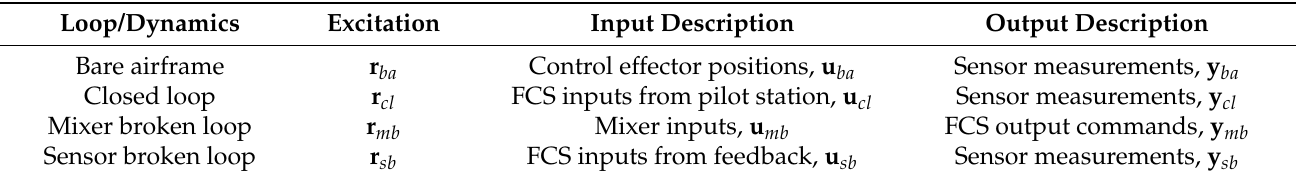
Table 1. A summary of the excitation, input, and output signals for different control